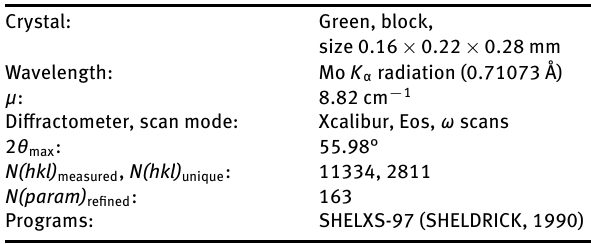
Table 1: Data collection and handling. Crystal: